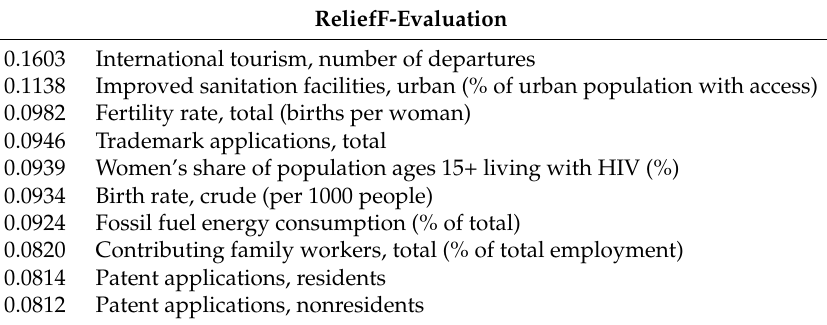
Table 5. Attribute evaluation with ReliefF. The value in the left column is the weight, computed by ReliefF (cf. Section 2.3.3 - ReliefF). The right column shows the name of the